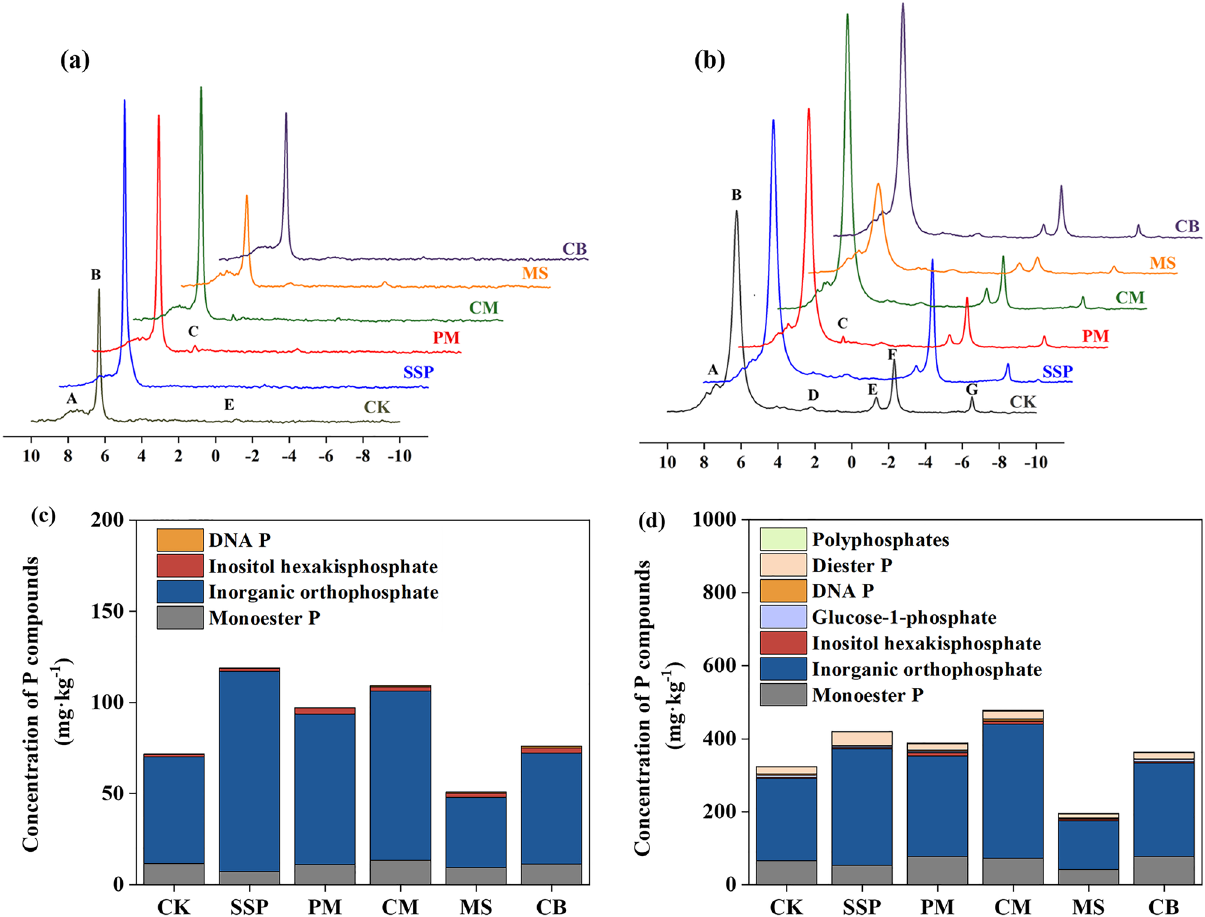
Figure 3. Liquid 31 P NMR spectra of NaOH-EDTA extracts of fluvo-aquic ( a ) and red soils ( b ) amended with different alternative P sources. Concentrations of P compounds in NaOH-EDTA extracts of fluvo-aquic ( c ) and red soils ( d ) by 31 P-NMR. In the upper spectrum, the shift positions of the different P compounds are indicated. A: Monoester P (7.19 to 7.58 ppm); B: Inorganic orthophosphate (6.18 to 6.34 ppm); C: Inositol hexakisphosphate (4.38 to 4.49 ppm); D: Glucose-1-phosphate (3.13 to 3.43 ppm); E: DNA P (− 0.15 to − 0.36 ppm); F: Diester P (− 1.73, − 2.43 ppm); G: Polyphosphates (− 4.63 to − 5.83 ppm). CK: Control; SSP: